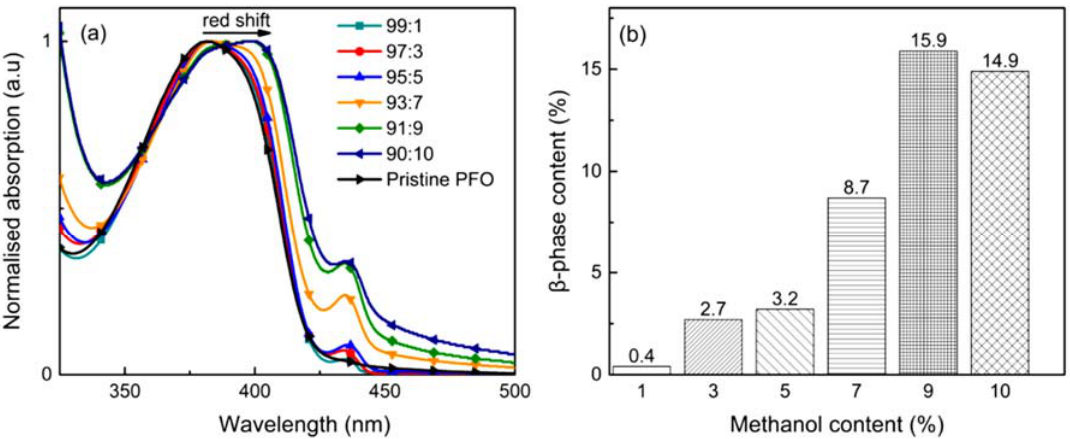
Figure 2. ( a ) UV-Vis absorption spectra of pristine PFO film and aggregated PFO films with different chloroform/methanol ratios and ( b ) the ratio of methanol content to the fraction of β -phase induced in aggregated films.